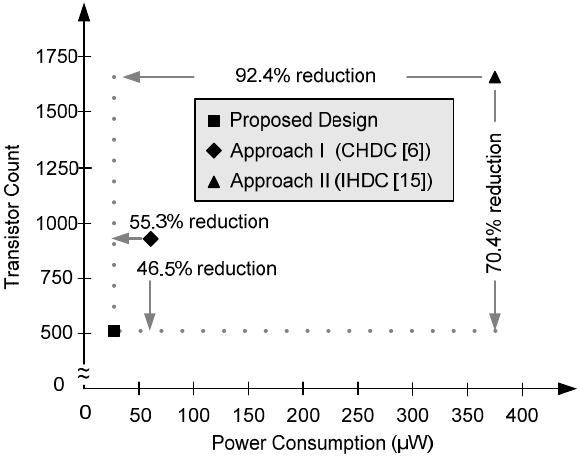
Figure 7. The power consumption and area comparisons of different delay cells.